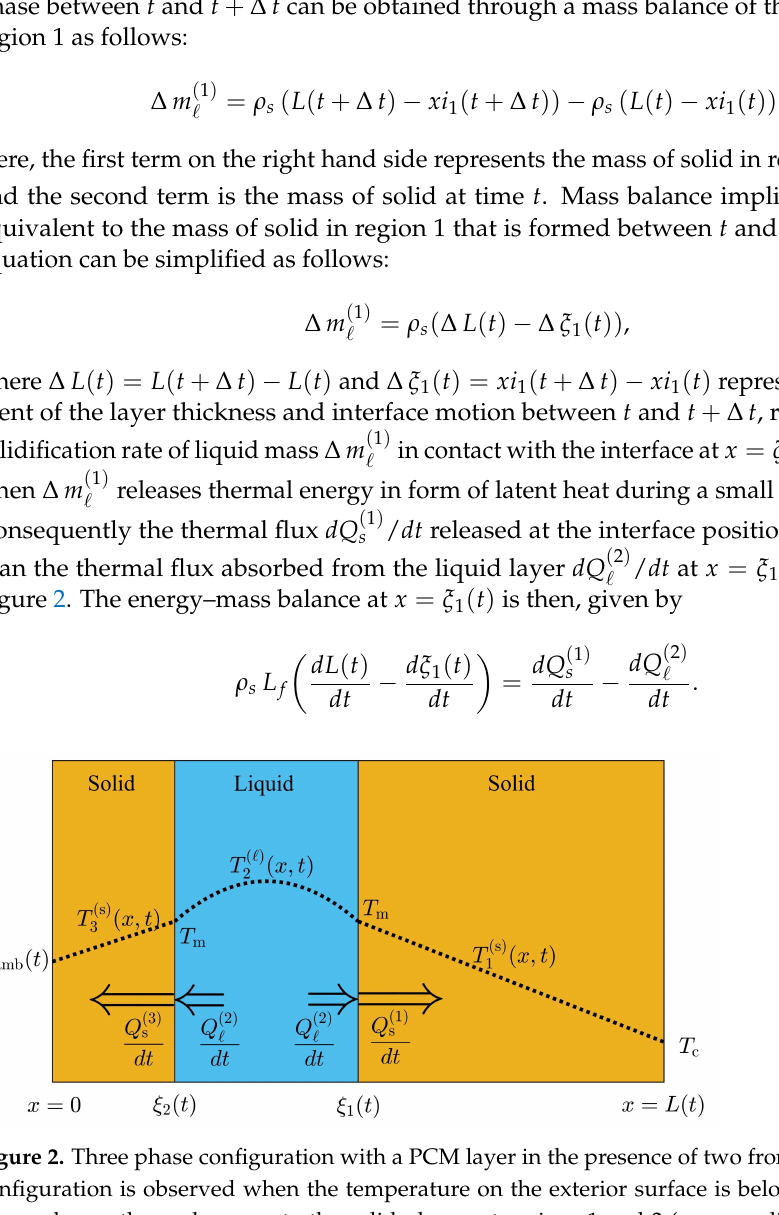
( s ) ( x , t ) , T ( (cid:96) ) ( x , t ) and T ( s ) ( x , t ) , respectively. The temperature on 2 3 1